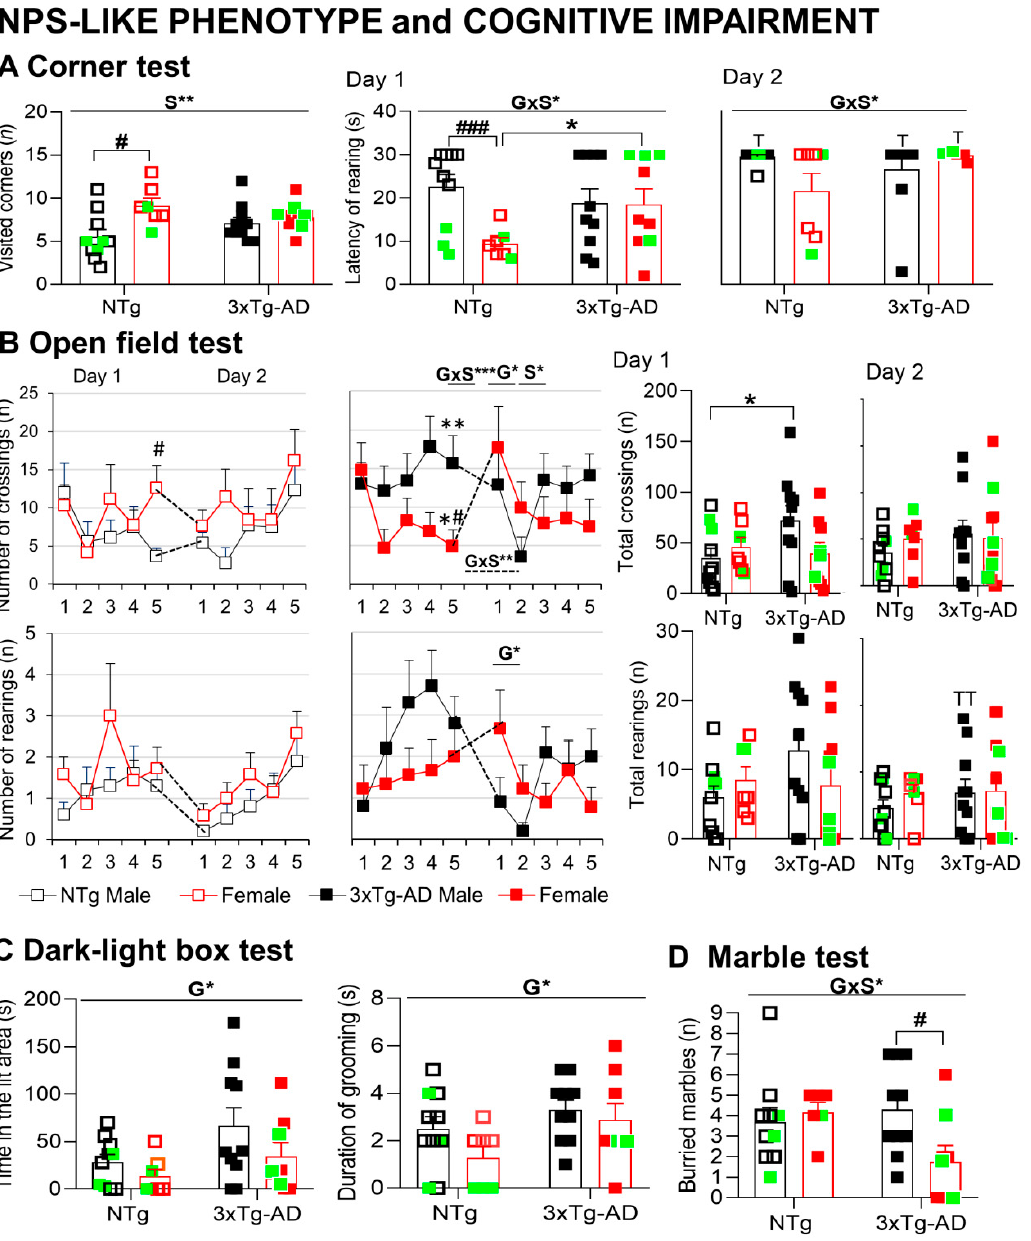
Figure 2. Mental health: Neuropsychiatric-like phenotype and cognitive impairment under different anxiogenic conditions. ( A ) Two-day corner test, ( B ) two-day open-field test, ( C ) dark–light box, ( D ) marble test. Results are the mean Bars illustrate the genotype groups, as indicated in the abscissae. Symbols are used to illustrate individual values of males (black, left panel) and females (red, right panel). In green: the no-survivors. Genotype (G) and sex (S) effects and GxS interaction were analyzed by 2 2 factorial ANOVA analysis, * p < 0.05, ** p < 0.01, *** p < 0.001 (above line). Time (T) × factor (day-by-day) was analyzed by repeated measures ANOVA, T p < 0.05, TT p < 0.01, vs. the corresponding day 1 results. Student t -test comparisons: * p < 0.05, ** p < 0.01, *** p < 0.001 vs. the corresponding NTg group; # p < 0.05, ### p < 0.001 vs. the corresponding male